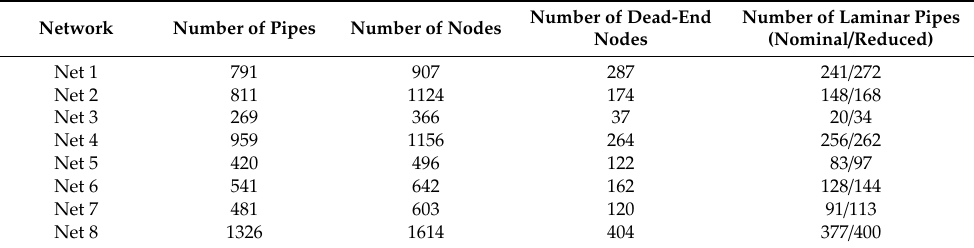
Table 12. Network Table 12. Network properties.